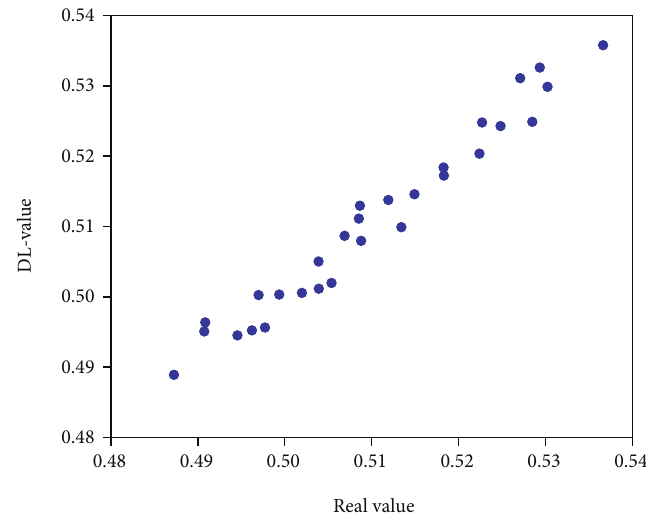
Figure 8: Linear correlation coe ffi cient distribution of English sentiment